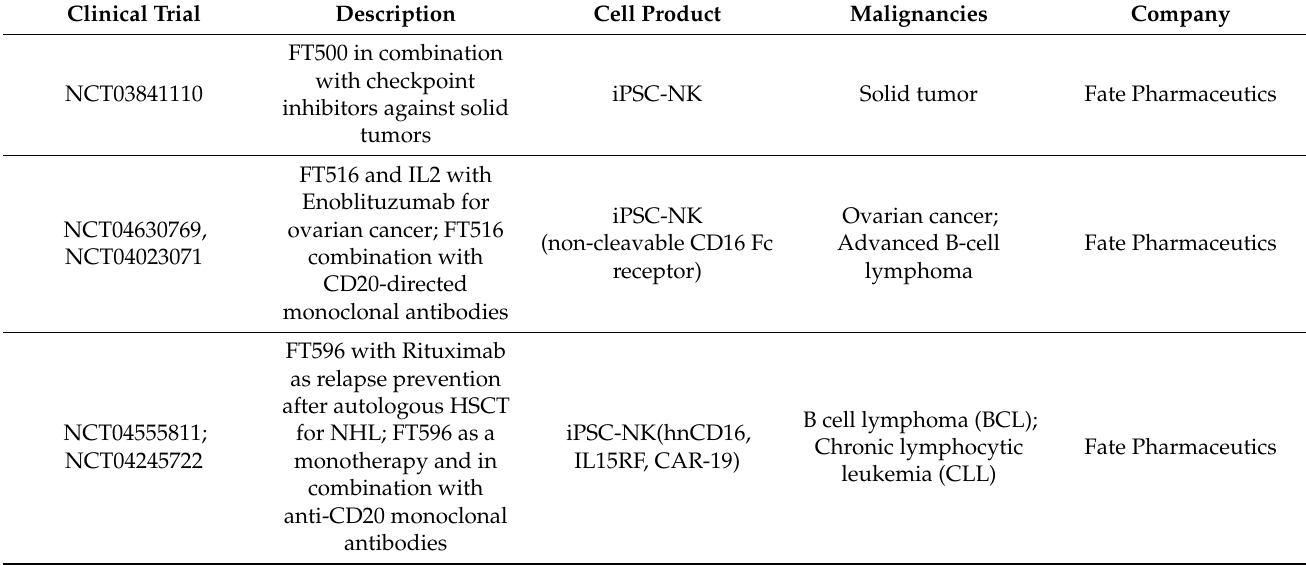
Figure 1. Development of cell therapy from autologous to allogeneic cell therapy. ( A ) PBMC-derived autologous cell therapy. Immune cells collected from cancer patients through leukapheresis are expanded and engineered ex vivo. The engineered cells are infused back to the same patients to fight against cancer. ( B ) PBMC-derived allogeneic cell therapy. Immune cells such as T cells, NK cells and other immune cells are collected from healthy volunteers and stored as banked cells after cell engineering and expansion. The banked cells are ready-to-use and can be utilized to treat multiple cancer patients. ( C ) iPSC-derived allogeneic cell therapy. Immune cells or other somatic cells are collected from healthy donors and reprogrammed to be stable iPSC lines. The reprogrammed iPSCs can be engineered and differentiated into different immune cells for treating multiple cancer patients. Table 1. Current allogeneic cell therapies in clinical